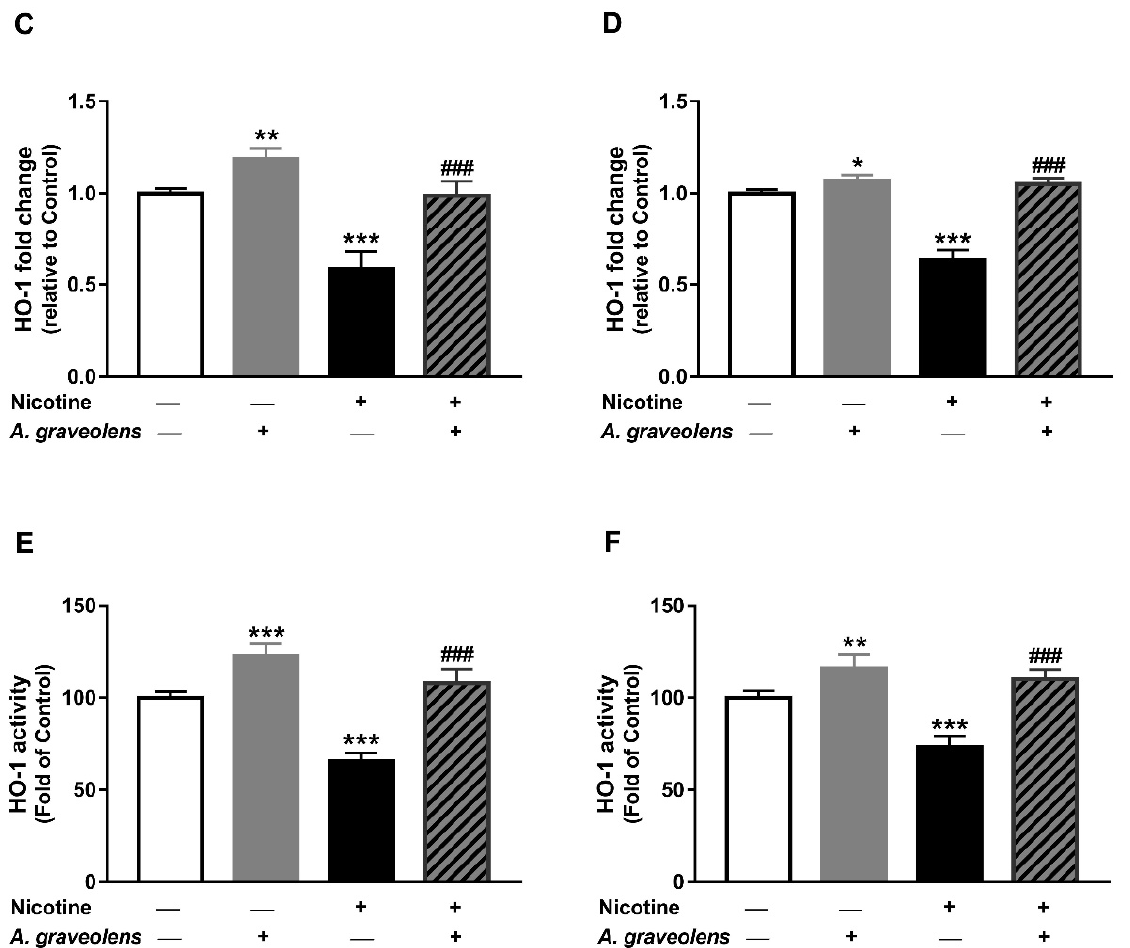
Figure 9. A. graveolens increased Nrf2 and HO-1 mRNA and HO-1 activity in liver and kidney of nicotine-exposed mice newborns. Data are mean ± SEM, n = 8. * p < 0.05, ** p < 0.01 and *** p < 0.001 versus Control and ### p < 0.001 versus nicotine: ( A ) Liver Nrf2 mRNA; ( B ) Kidney Nrf2 mRNA; ( C ) Liver HO-1 mRNA; ( D ) Kidney HO-1 mRNA; ( E ) Liver HO-1 activity; ( F ) Kidney HO-1 activity.